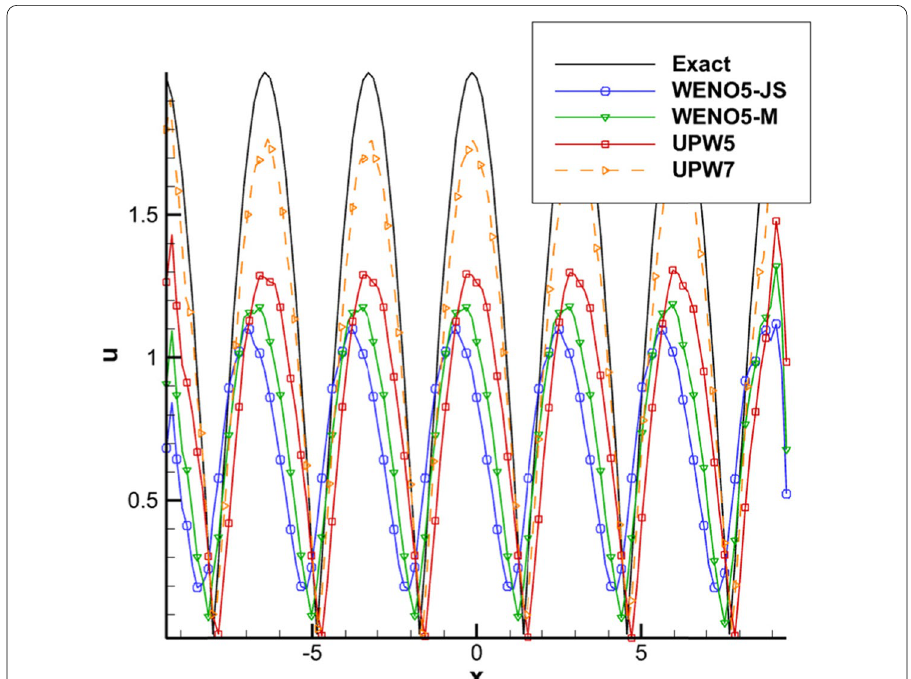
Fig. 11 Envelopes for T 1 for the hyperbolic equations under the conditions N x = with k 1 ω 1 6, k 2 8, and ω 2 12 for different spatial schemes and RK = = = =